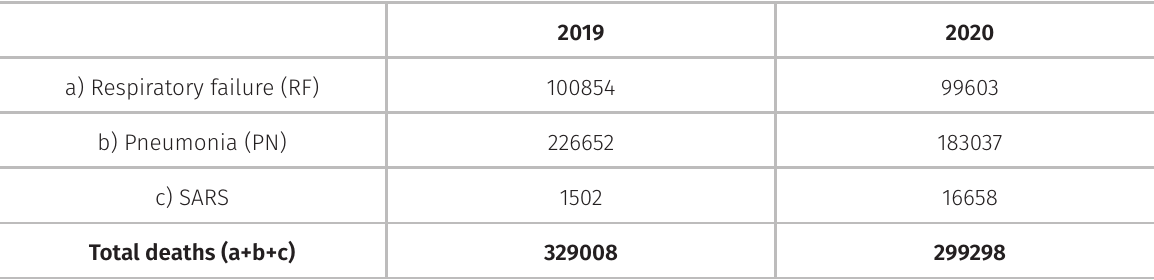
Table I. Deaths by respiratory diseases for years of 2019 and 2020 in